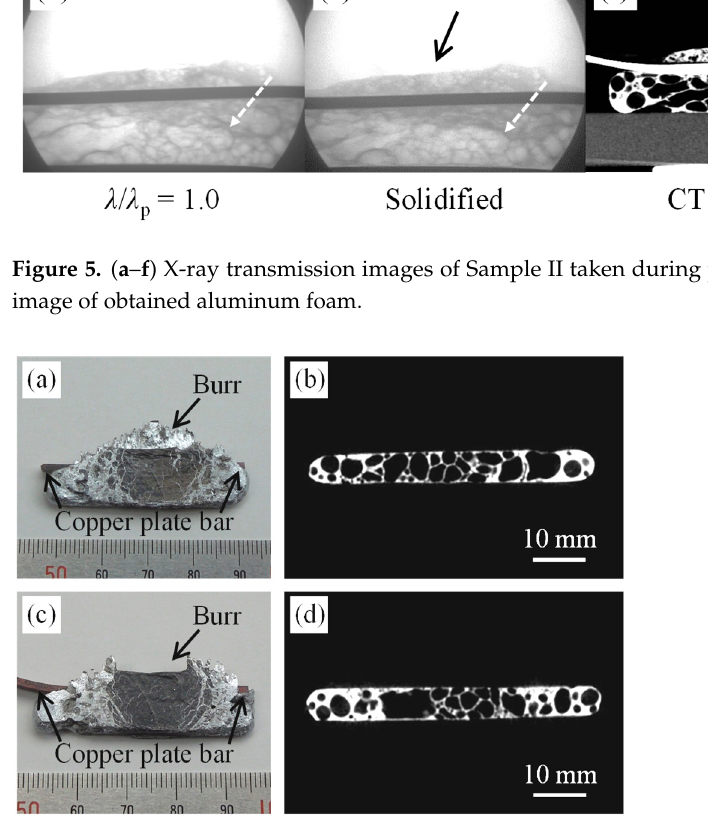
Figure 6. ( a ) Sample I and ( b ) its cross-sectional X-ray CT image in thickness direction. ( c ) Sample II and ( d ) its cross-sectional X-ray CT image in thickness